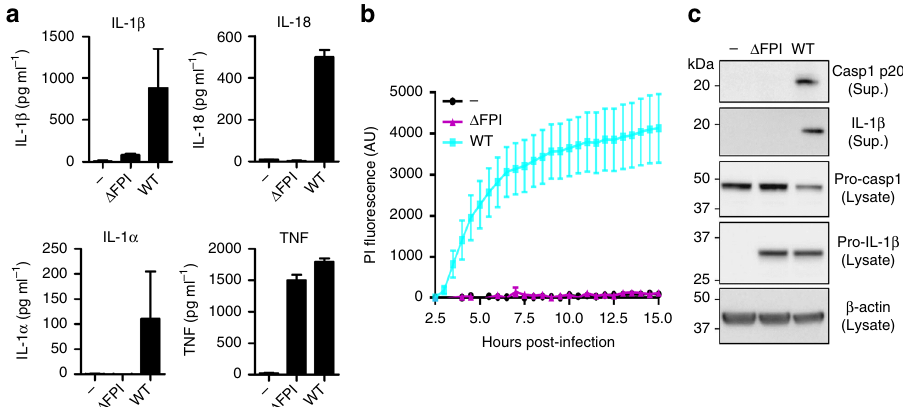
Fig. 1 F. novicida FPI-encoded T6SS is required to trigger in fl ammasome activation in hMDMs. a – c hMDMs were infected at a multiplicity of infection of 10 with wild-type (WT) F. novicida or a mutant deleted of the Francisella pathogenicity island (FPI) encoding the type VI secretion system (T6SS). a Interleukin (IL)-1 β , IL-18, IL-1 α , and tumor necrosis factor (TNF) levels were quanti fi ed by ELISA at 9 h post-infection. b Cell death was assessed in real-time by measuring propidium iodide (PI) incorporation/ fl uorescence every 30 min (AU arbitrary units). c Caspase-1 and IL-1 β processing and protein levels were evaluated in the supernatant (Sup.) and the lysate of hMDMs infected or not for 9 h. a , b Values represent the mean ± standard deviation from two to three independent experiments. c One experiment representative of two independent experiments is